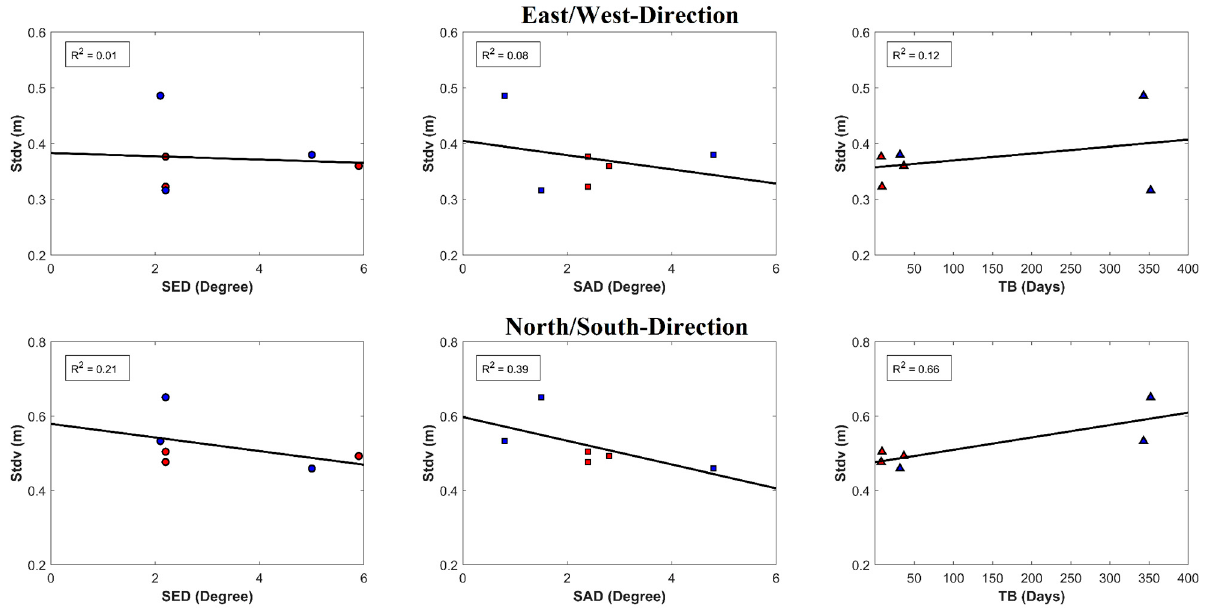
Figure 10. Relationship between the SED, SAD, TB, and uncertainties in the East/West ( top ) and North/South ( bottom ) directions after imposing a limitation to SED and SAD (SED ≤ 10° and SAD ≤ 10°). The red and blue colour indicate the first and second time series POT results, respectively. The circle, square, and triangle markers represent the SED, SAD, and TB, respectively. The black lines represent the best linear fits.